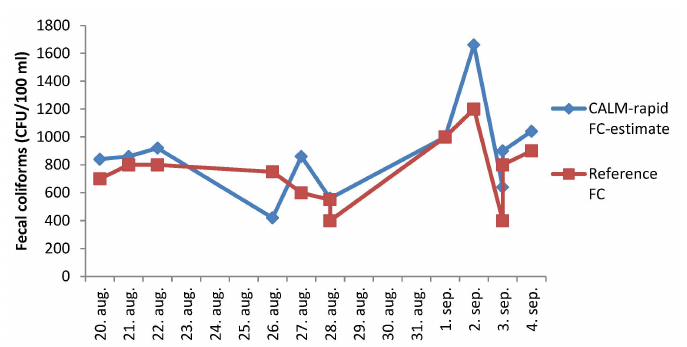
Figure 4. The concentration of fecal coliforms in Akerselva (Myraløkka) at different dates during the late summer period of 2014, measured by the reference method and the fully automated CALM using a method based on 2-h measurement of the GAL activity.